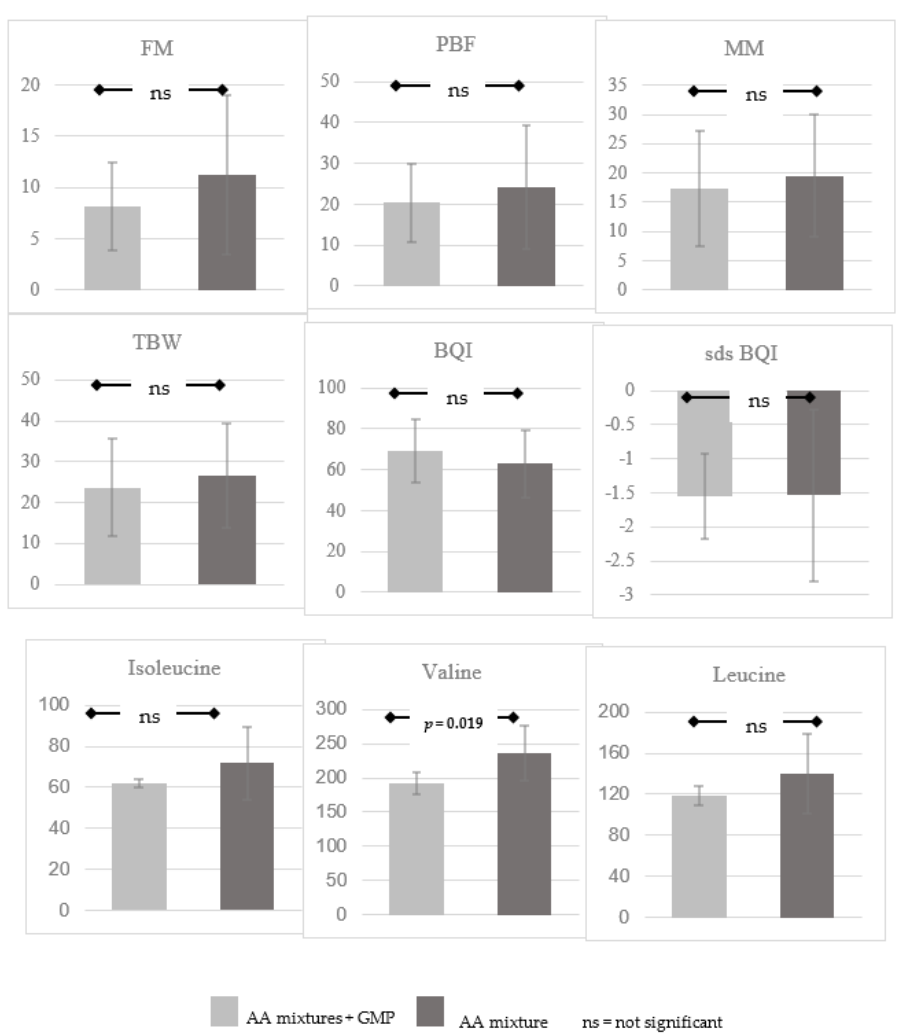
Figure 1. Comparison of parameters according to type of protein substitute.